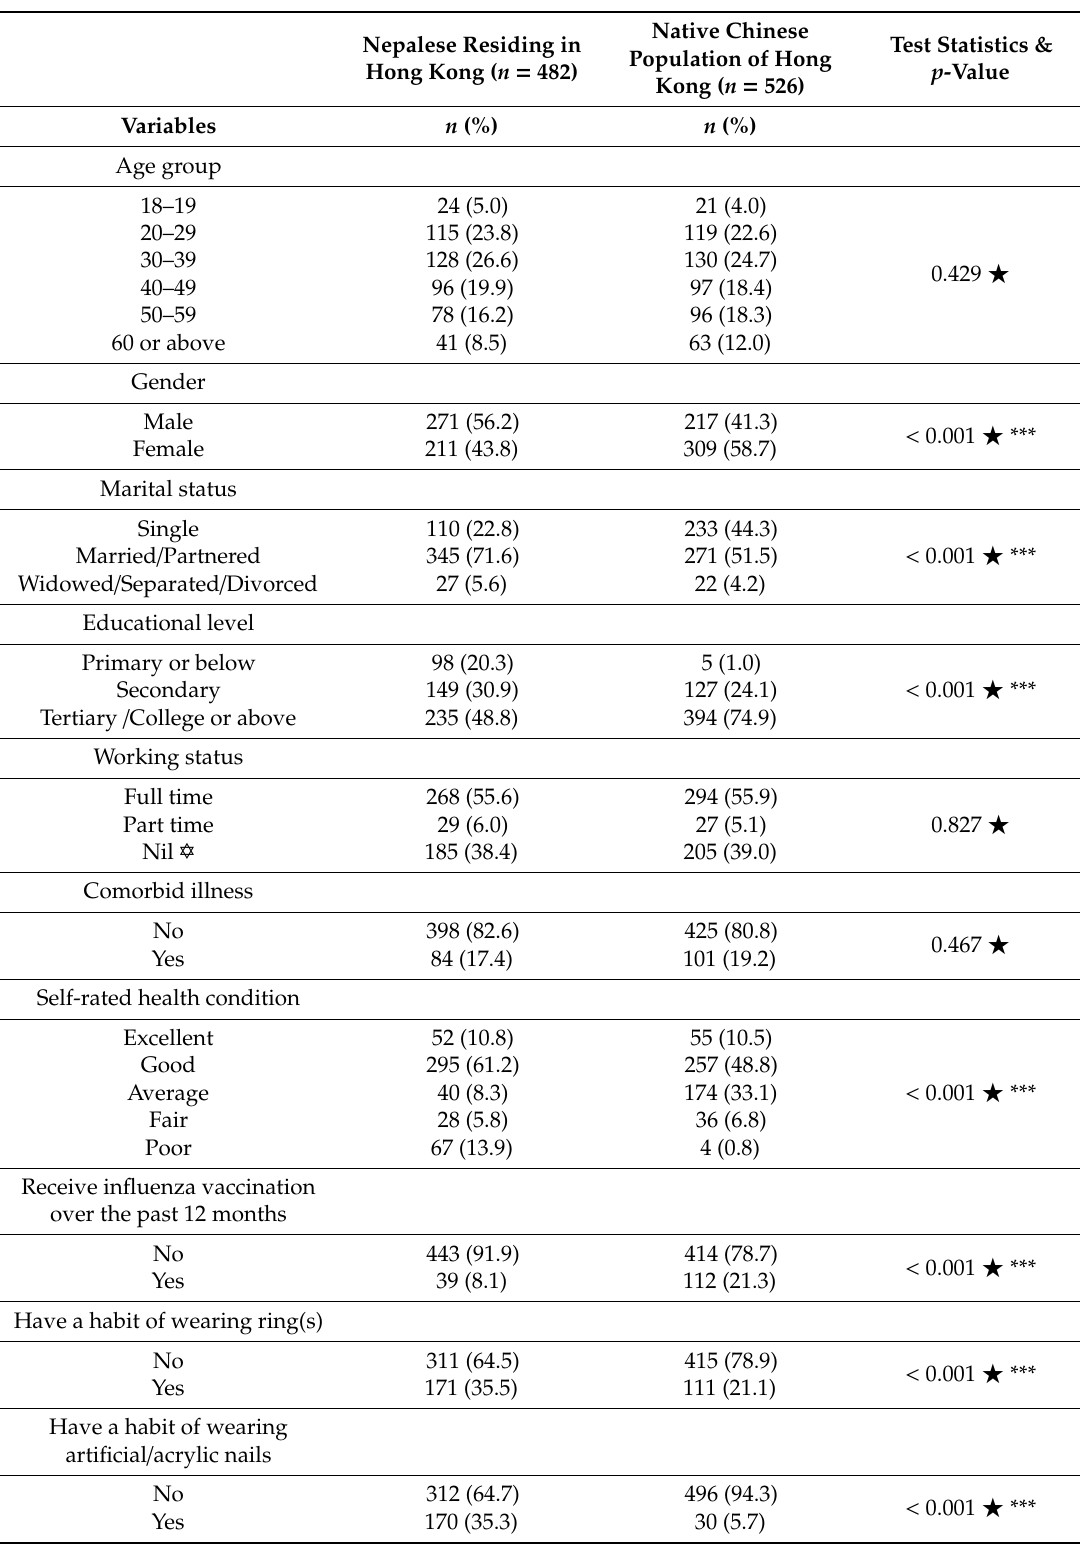
Table 1. Sociodemographic characteristics of